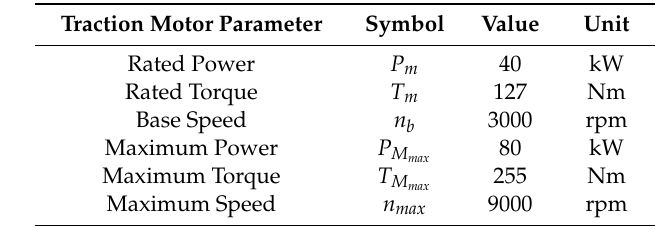
Table 4. Traction motor parameter [8].